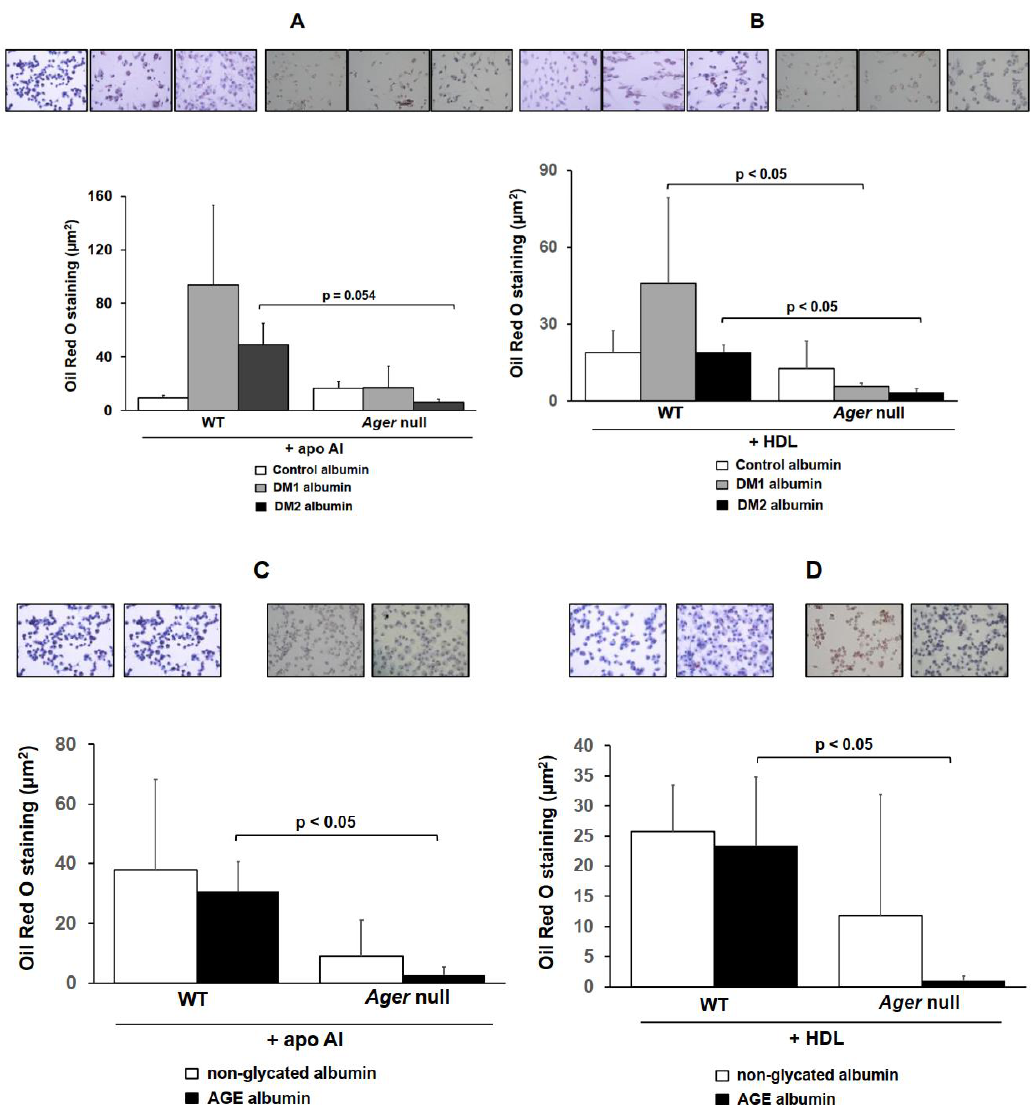
Figure 2. Intracellular lipid staining in macrophages treated with non-glycated, AGE, control, DM 1 or DM 2 albumin. Bone marrow-derived macrophages (BMDMs) from C57BL / 6 Wild-type (WT, n = 3) and RAGE knockout (RAGE-KO, n = 3) mice were loaded with acetylated LDL (50 µ g / mL) for 24 h. Cells were treated for 48 h with control, DM 1 or DM 2 albumin ( A , B ) or with non-glycated or AGE albumin ( C , D ) (1 mg / mL in DMEM) alone or in the presence of apo AI (30 µ g / mL) or HDL (50 µ g / mL) for 6 h to determine the Oil Red O staining. Representative images (400x magnification). Student’s t test; mean ±